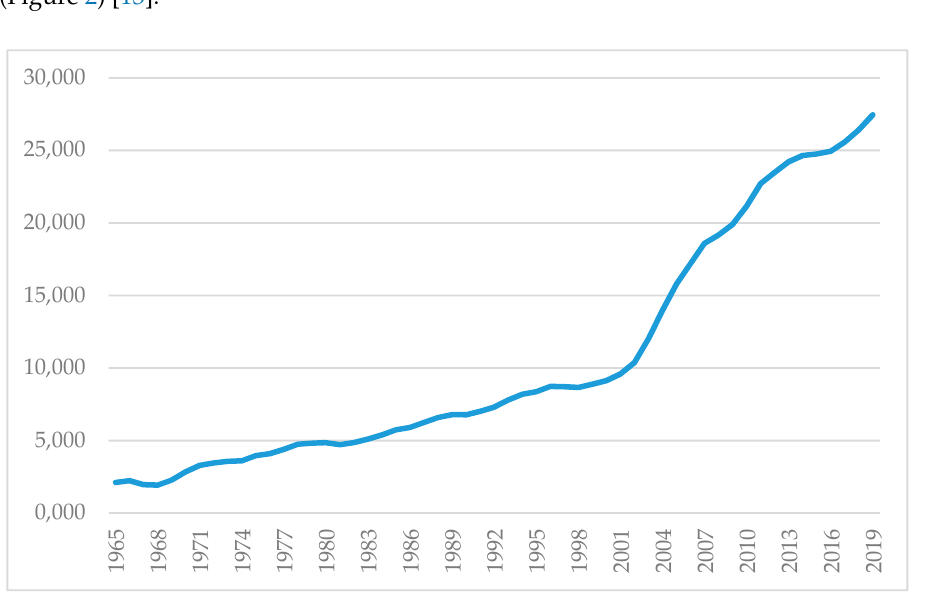
Figure 1. Energy consumption per capita (kWh) in China (according to the data source [14]).